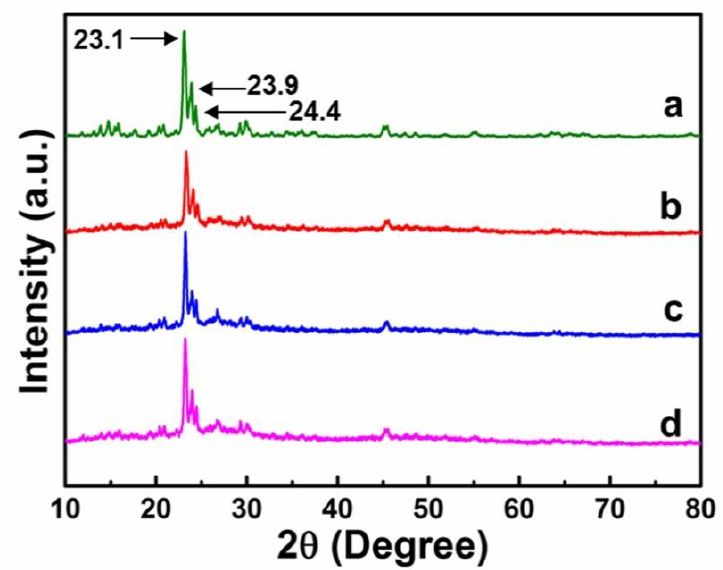
Figure 4. XRD patterns of zeolite ZSM-5 and its immobilized catalysts: ( a ) ZSM-5; ( b ) ZSM-5-HO-[PECH-MIM]Cl/[ZnBr 2 ]; ( c ) ZSM-5-HOOC-[PECH-MIM]Cl/[ZnBr 2 ]; and ( d ) ZSM-5-H 2 N-[PECH-MIM]Cl/[ZnBr 2 ]. 2.4. Thermogravimetry (TG) and Derivative Thermogravimetry (DTG)